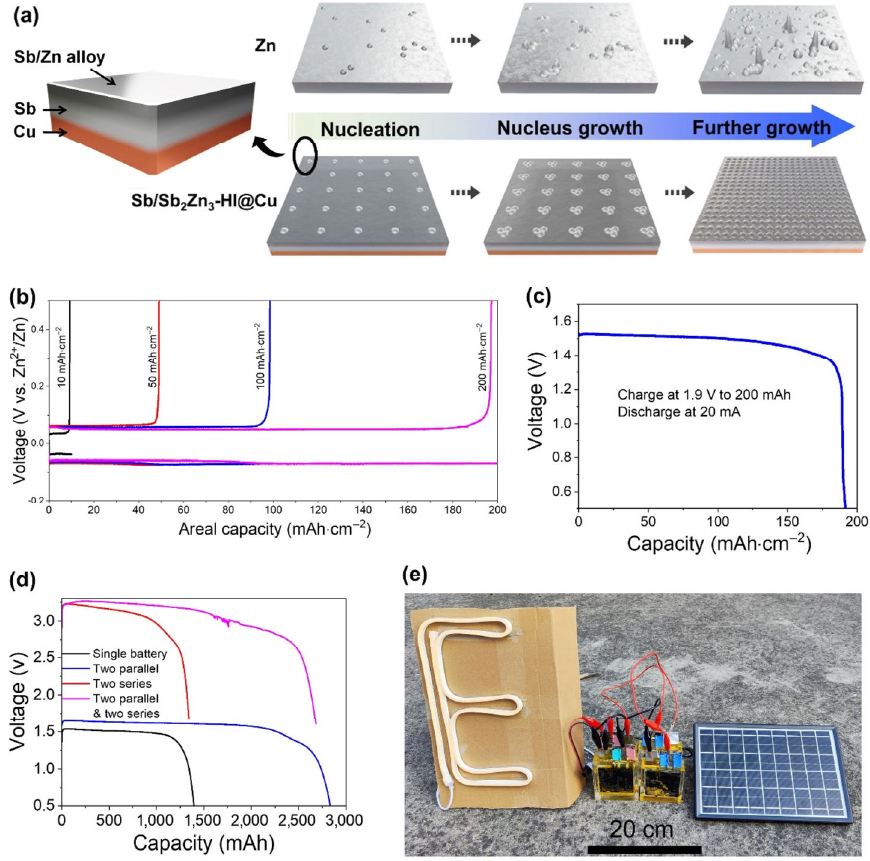
Figure 1 (a) Schematic diagrams of Zn electrodeposition on Zn and Sb/Sb 2 Zn 3 -HI@Cu substrates. (b) Charge and discharge curves of the Zn|Sb@Cu half-cells at different capacities with a constant current density of 20 mA·cm –2 and a cut off voltage of 0.5 V vs. Zn 2+ /Zn. (c) Discharge curve of the asymmetric anode-free Zn-Br 2 battery, where the battery has a carbon felt cathode of 20 cm 2 and a Sb@Cu anode of 1 cm 2 . (d) Discharge curves of the Zn-Br 2 battery modules in different connections. (e) Solar powered Zn-Br 2 battery energy storage